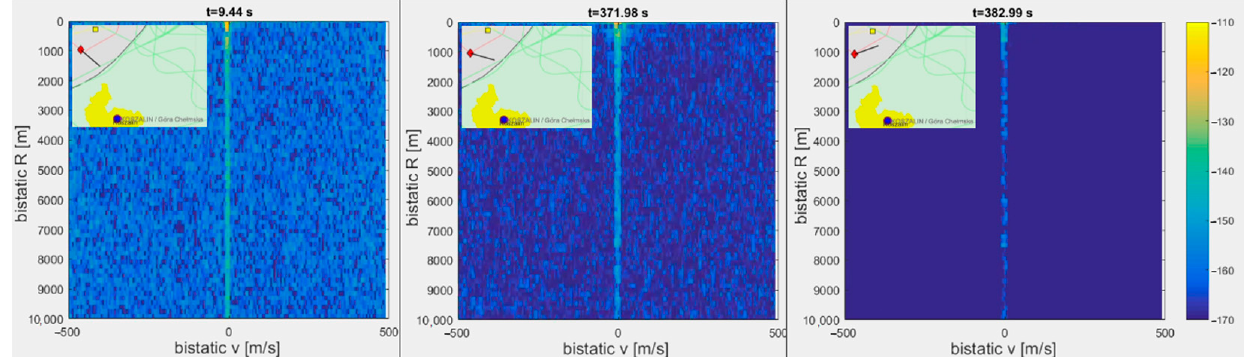
Figure 11. Change of clutter intensity caused by turning of platform with antenna array. The residual clutter structure in marine PCL installation also depends on the sea state as determined by weather conditions. The clutter image observed during calm seas is depicted in Figure 12, with cross-sections for different bistatic ranges ( R ). For this experiment, the DAB transmitter (218.64 MHz) was selected for illumination, and the integration time was extended to 5 s to improve the resolution in Doppler frequency